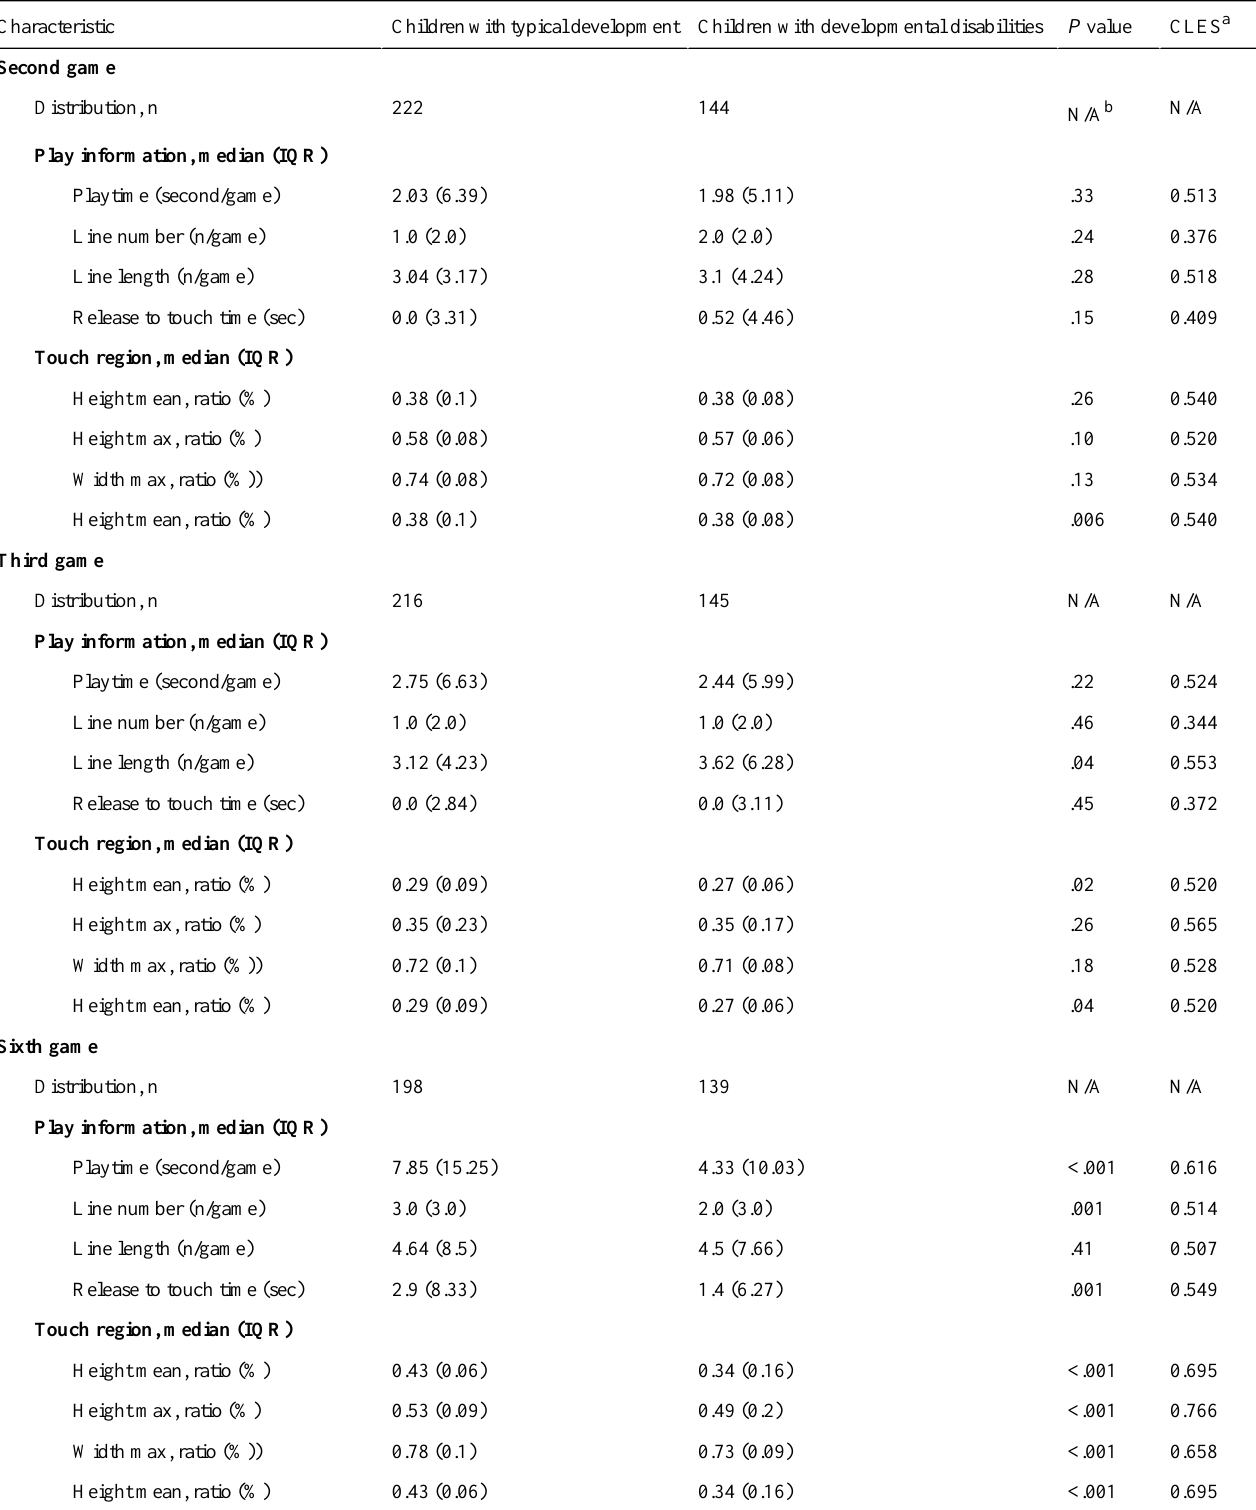
Table 2. Comparison of movement features between children with typical development and children with developmental disabilities in each game.